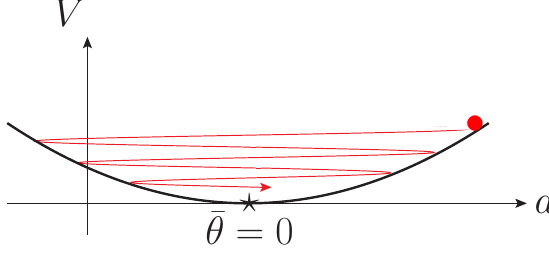
Figure 2. The almost flat axion